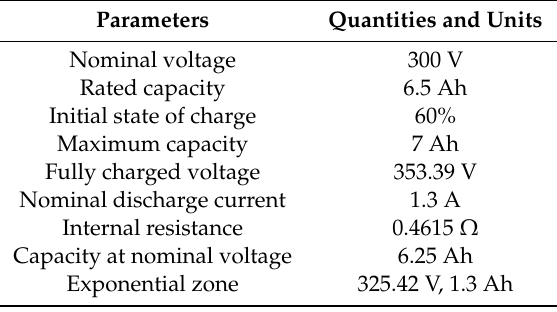
Figure 9. Boost converter model in Simulink-Matlab software.